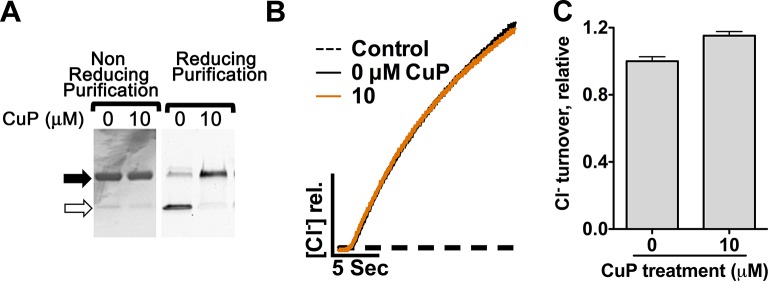
Cross-linking of Y419C ClC-ec1.(A) Y419C analyzed on non-reducing SDS-PAGE. Solid and open arrows indicate positions of dimeric (cross-linked) and monomeric ClC-ec1 respectively. Y419C purified under non-reducing conditions (gel at left) forms spontaneous crosslinks. Y419C purified under reducing conditions (gel at right) is largely uncross-linked but becomes cross-linked upon addition of 10 µM CuP. (B) Representative raw traces showing Cl- flux through Y419C-reconstituted proteoliposomes. (C) Summary data show that the Y419C crosslink has no significant effect on activity (error bars show SEM for n=4–6).